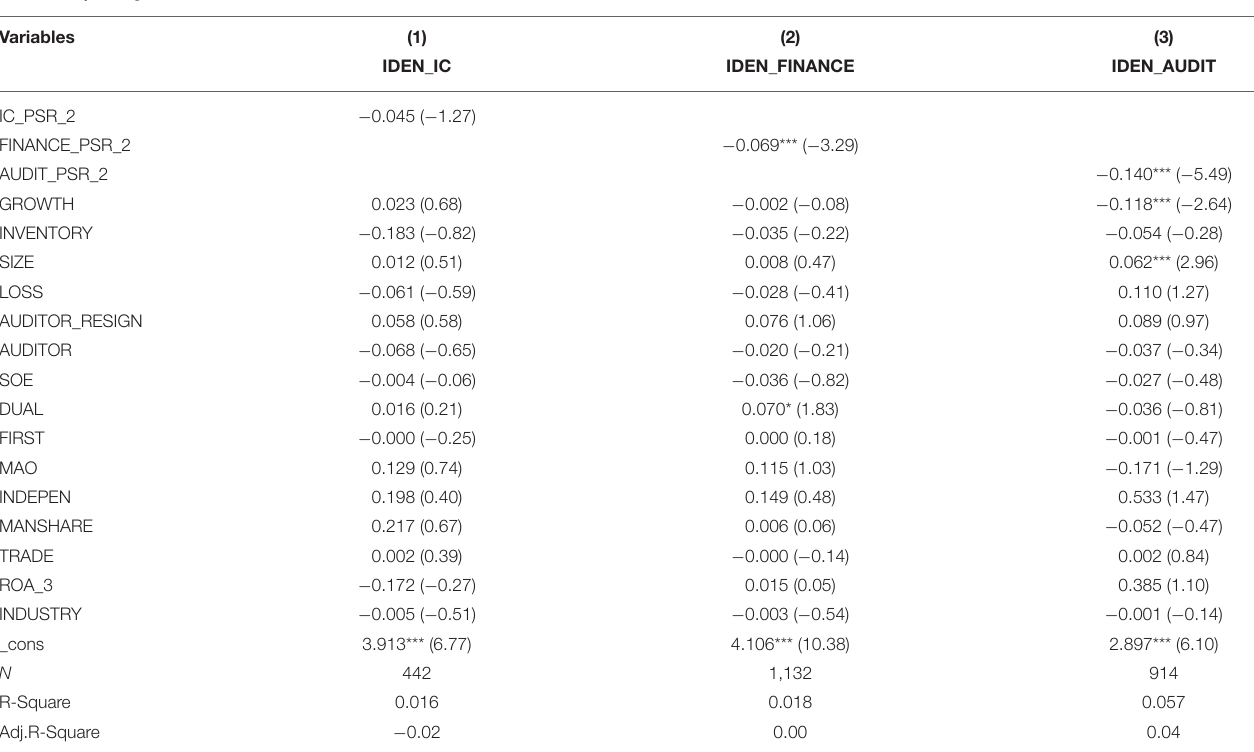
TABLE 11 | Endogenous test: total